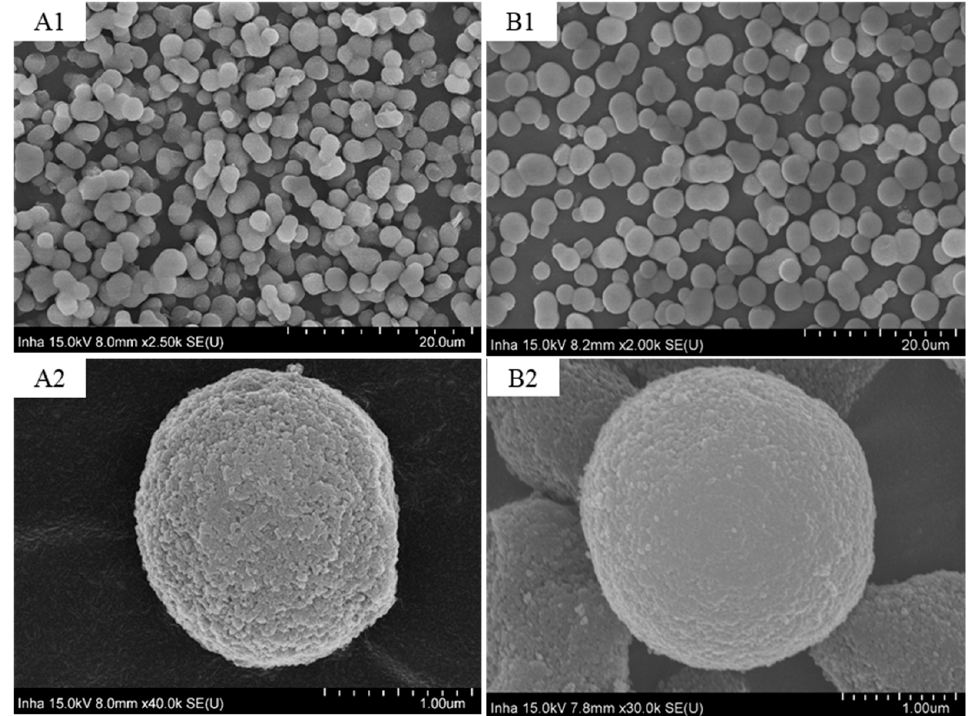
Figure 1. FE-SEM images of bare SM particles ( A1 , A2 ) and C18-bound SM particles ( B1 , B2